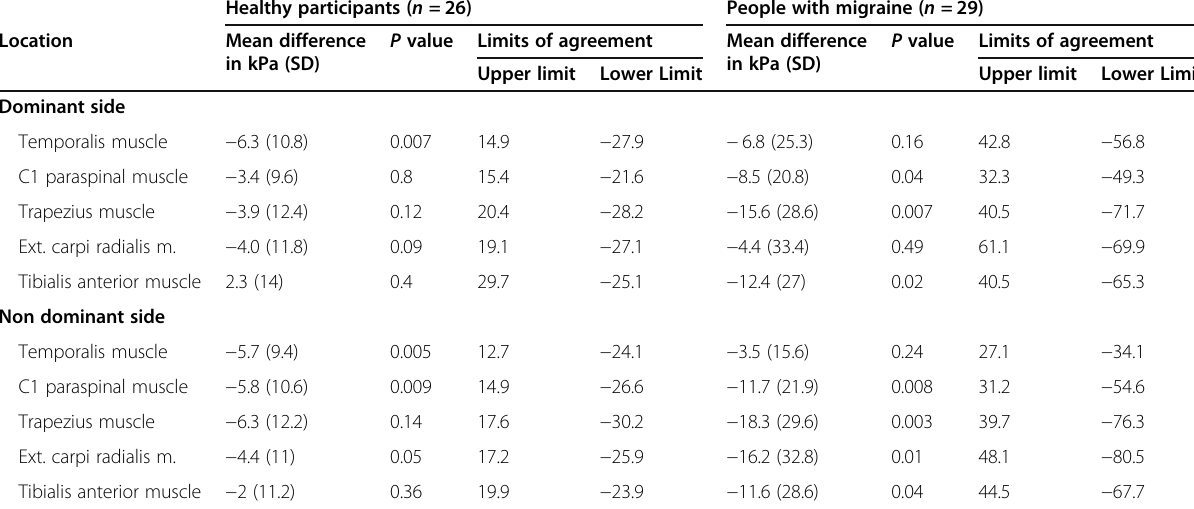
Table 3 Mean difference of all locations between the digital and analogue algometer and limits of agreement in people with healthy participants and people with